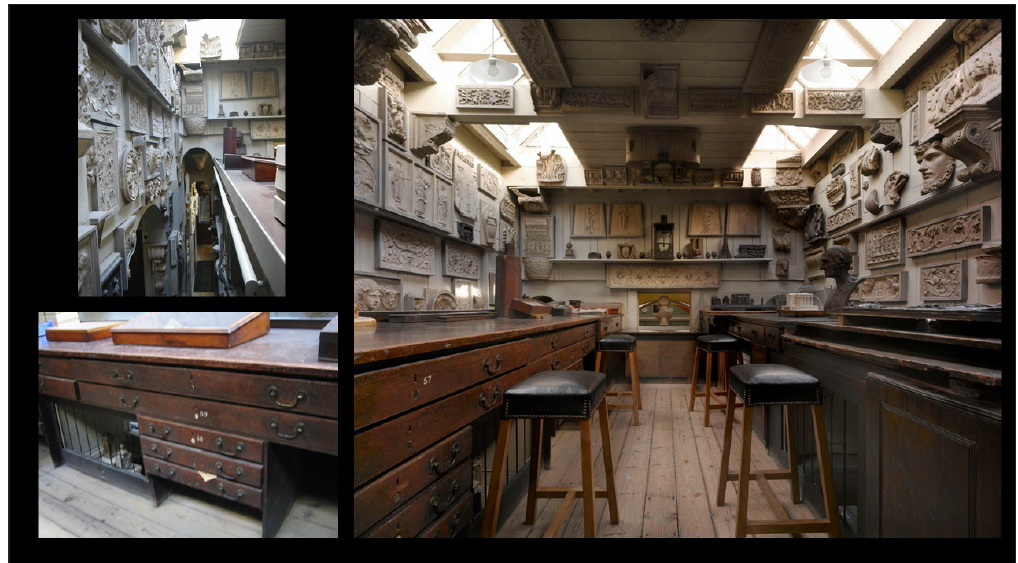
Fig. 3 : Views of the surviving upper drawing office (or students’ room) at Sir John Soane’s Museum. Photos: © Sir John Soane’s